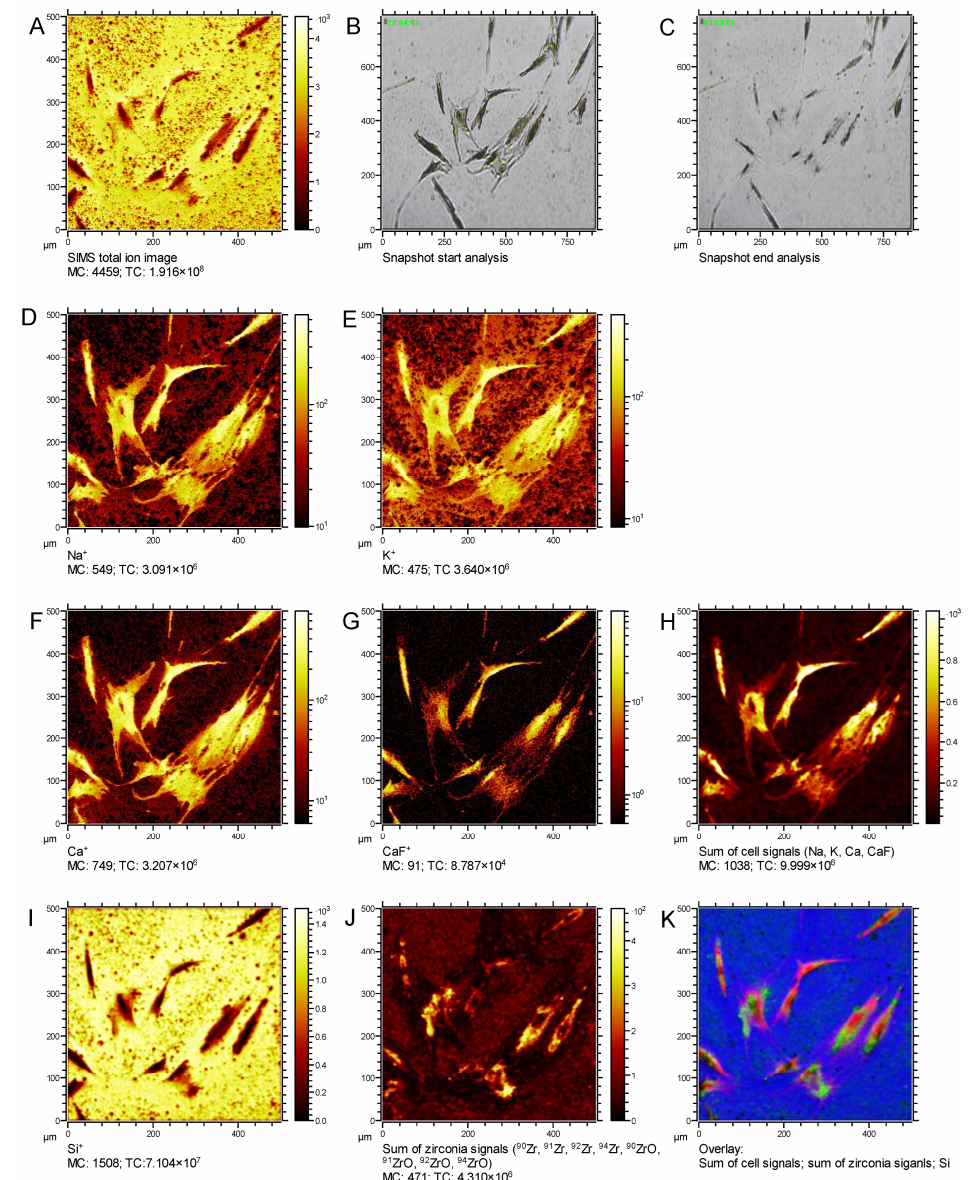
Figure 2. Depth-integrated SIMS-images of an erosion experiment performed with cells incubated with PH-ZrNP for 24 h. The image panel includes a total secondary ion image ( A ), optical images before ( B ) and after erosion ( C ), images of the cellular components sodium ( D ), potassium ( E ), calcium ( F ) and calcium fluoride ( G ) and of the sum of these cellular signals ( H ), a silicon ( I ) and zirconia ( J ) image. ( K ) RGB overlay of the cellular ( H ), zirconia ( J ) and substrate signals ( I ) signals. Zirconia particles are visualized in green, the cell bodies are red and the silicon substrate is given in